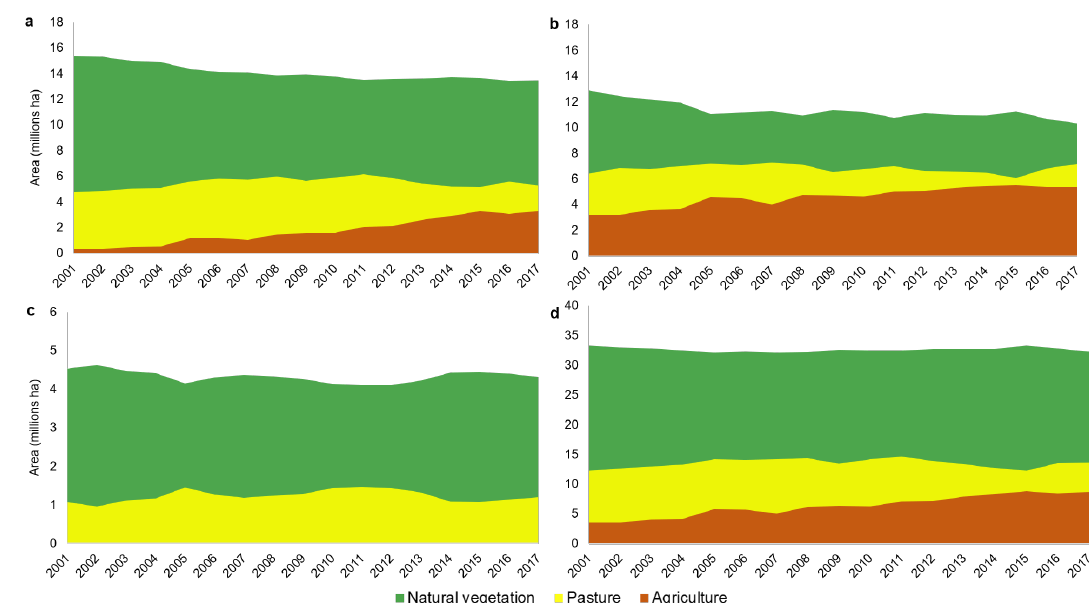
Figure 3. Amount of Natural Vegetation, Agriculture (single and double crop), and Pasture areas, from 2001 to 2017, in Mato Grosso State. ( a ) Amazon biome, ( b ) Cerrado biome, ( c ) Pantanal biome, and ( d ) Mato Grosso State (Amazon + Cerrado + Pantanal).